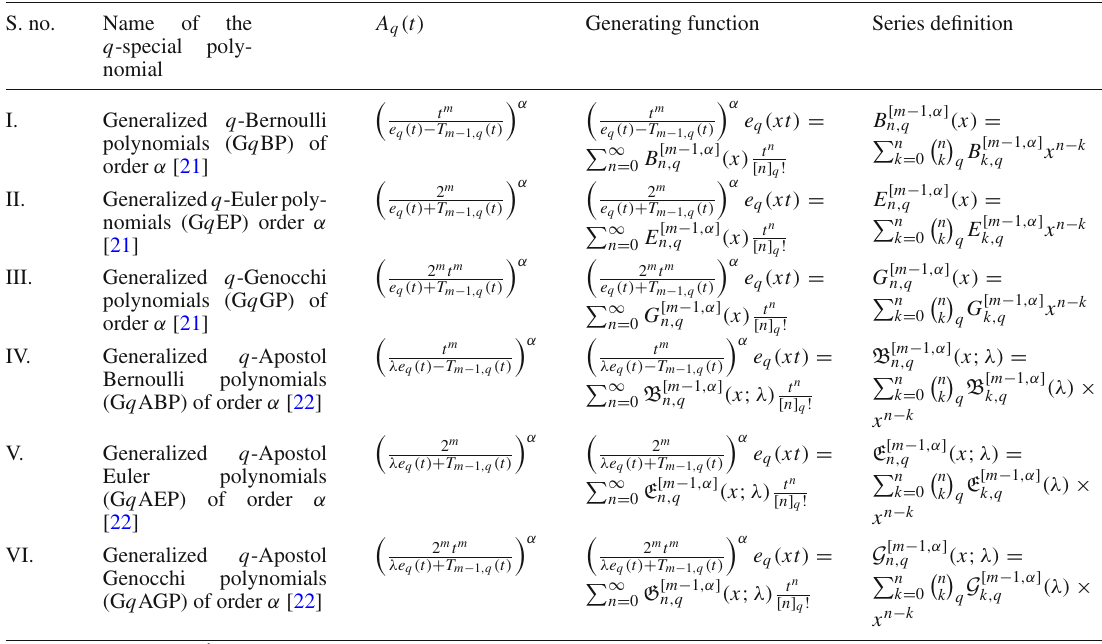
Table 4 Certain generalized members belonging to q -Appell family S.